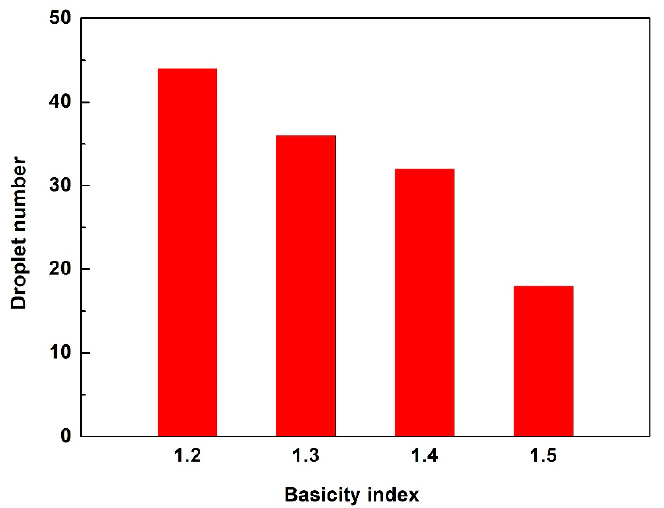
Figure 2. Effect of slag basicity index on the overall number of silicon droplets at the silicon–slag interface (inspection area: 1 mm × 1 mm). Table 3. Statistics of silicon droplets with different sizes (in a 1 mm × 1 mm area).